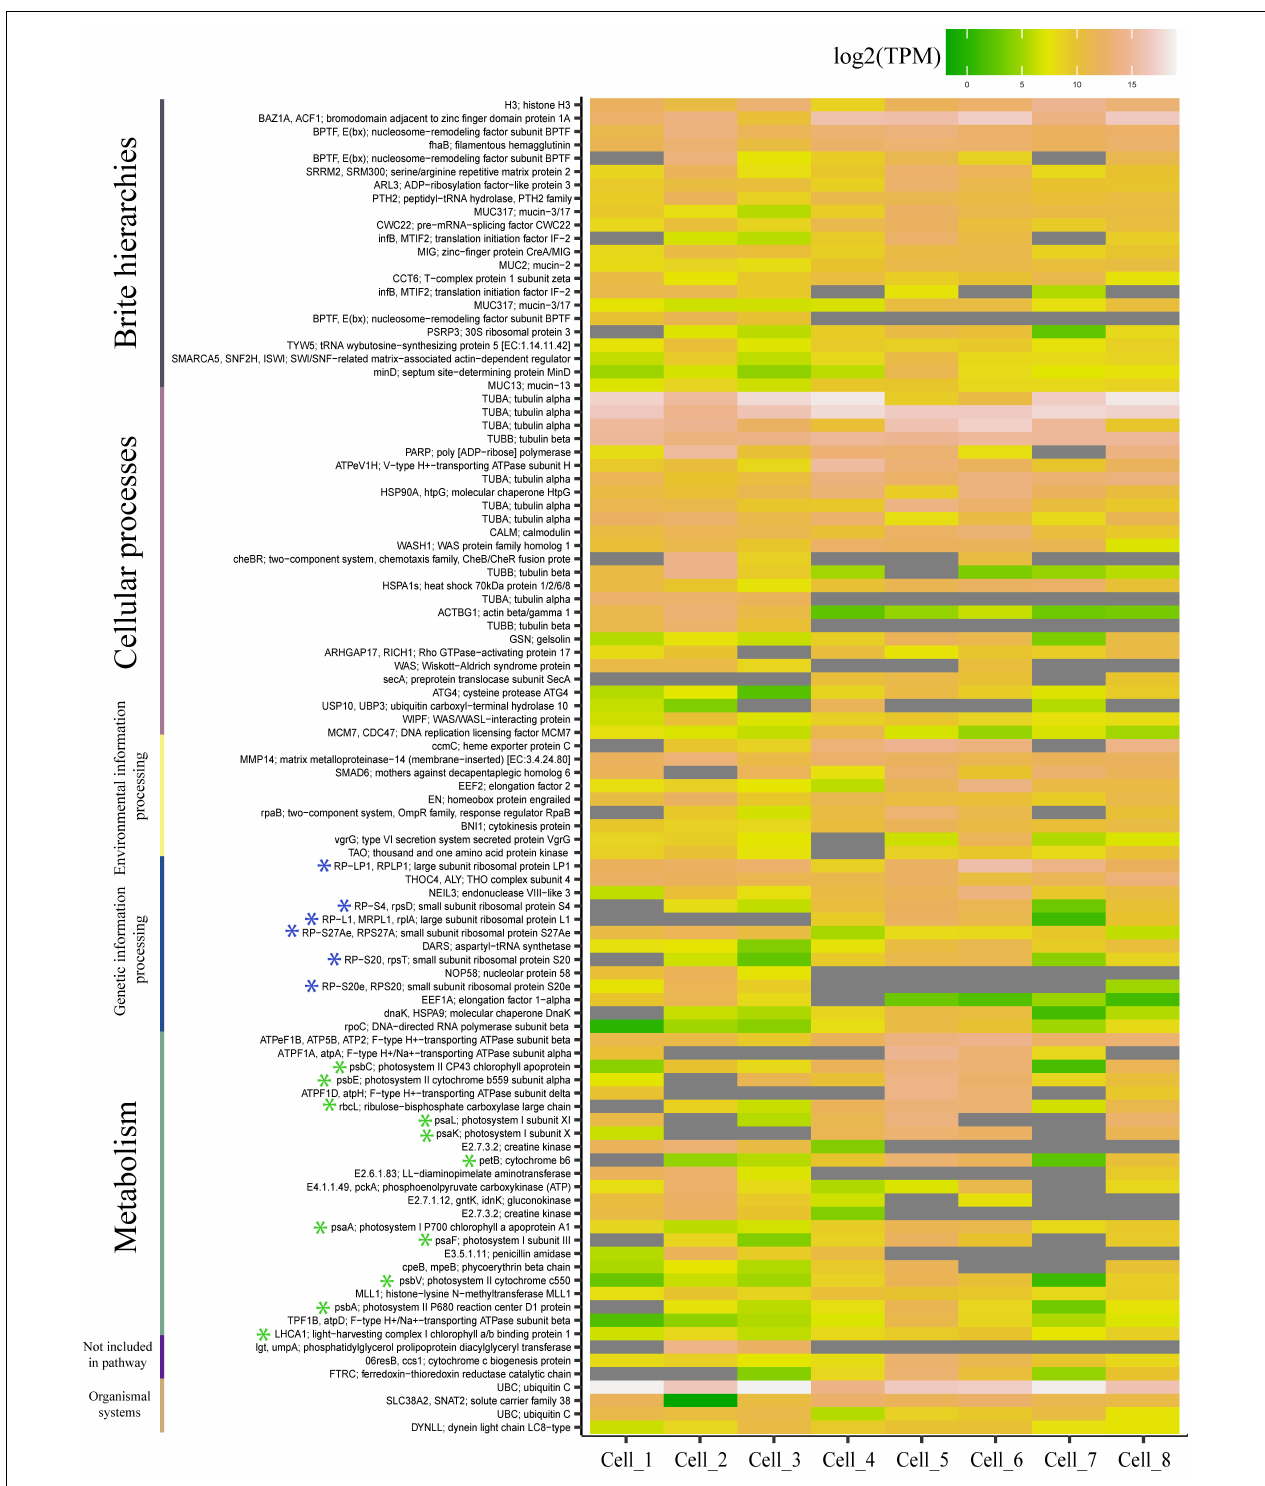
FIGURE 3 | Heatmap representing the 100 most expressed transcripts of prey origin and their corresponding pathways according to the Kyoto Encyclopedia of Genes and Genomes. The expression values are provided for each separate cell and are shown as transcripts per million (TPM). Transcripts that have not been detected are represented in gray. Transcripts of ribosomal and chloroplast origin are highlighted with blue and green asterisks, respectively. The figure was generated using the R package ggplot2.